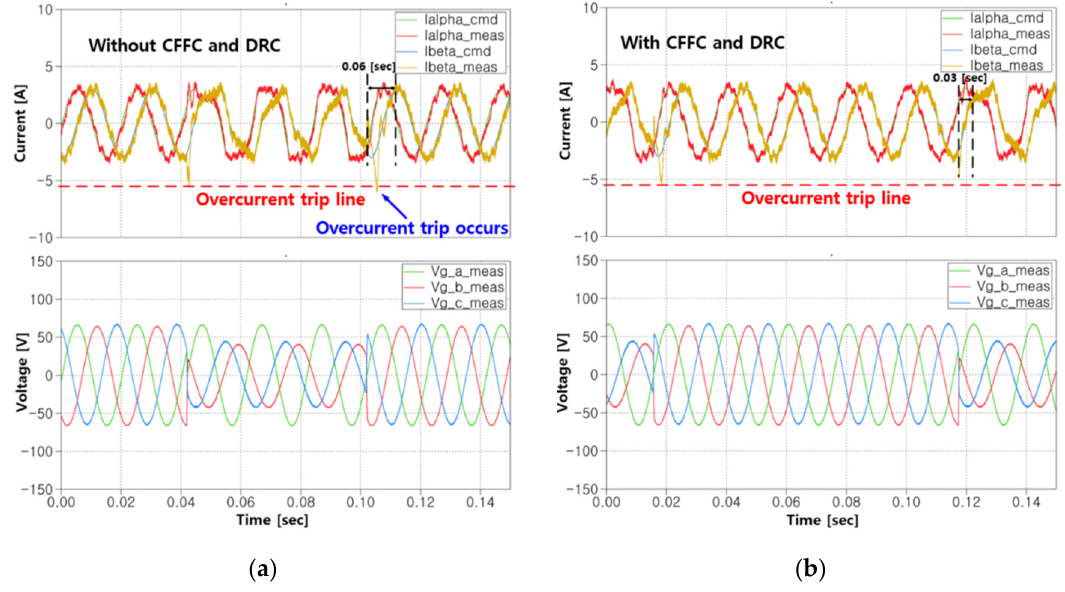
Figure 14. When line-to-ground fault occurs, experimental results of the stationary reference frame grid currents and abc reference frame grid voltages ( a ) without CFFC and DRC and ( b ) with CFFC and DRC. Table 6. Experiment results of GCI system phase current THD when line-to-ground fault occurs. Transient Response